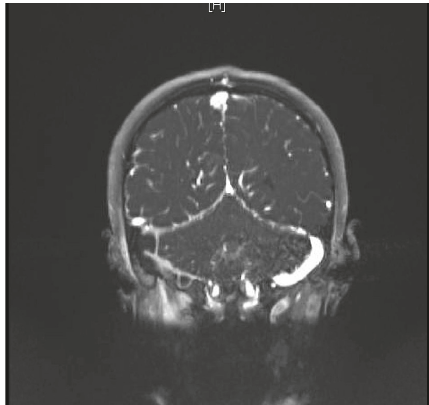
Figure 2: Coronal view of the MRI brain.